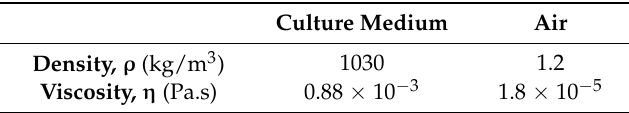
Table 1. Density and viscosity of the fluids in contact with the sensor at 37 ◦